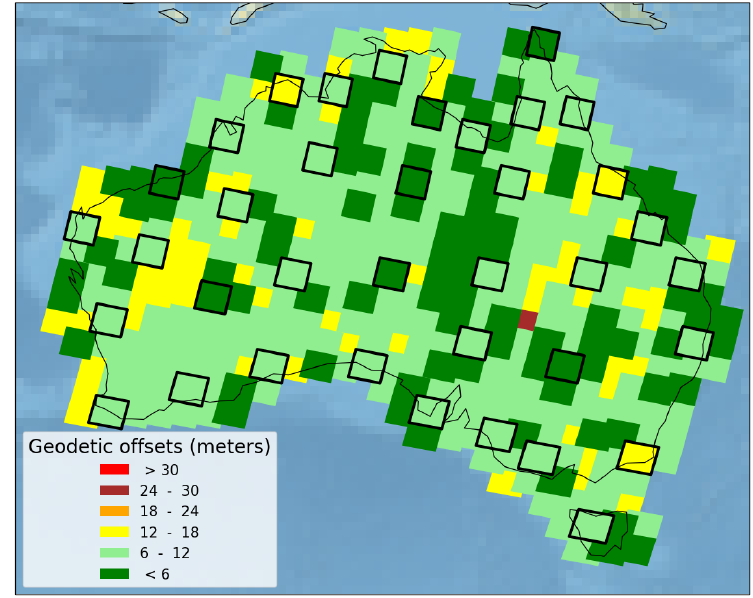
Figure 4. Plot of geodetic accuracy of Landsat 8 scenes after the AGRI-constrained triangulation process. A small number indicates that the scene’s pointing knowledge is consistent with the AGRI reference, while a large number is likely to indicate an error in the scene’s pointing knowledge, more so than any error in the adjustments to the GCPs. This should highlight images with poorer absolute pointing